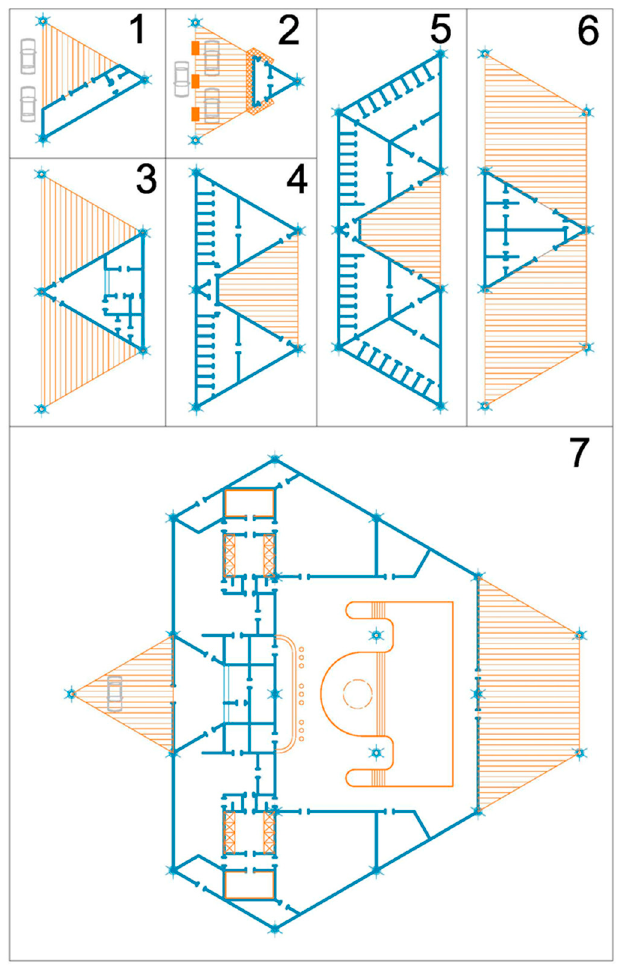
Figure 4. Planning solutions: 1—the Public transport stop; 2—the Automatic gas station (self-service); 3—the Catering point (16 seats); 4—the Public toilet; 5—the Public toilet and shower; 6—the Picnic area; 7—the Wellness pavilion.